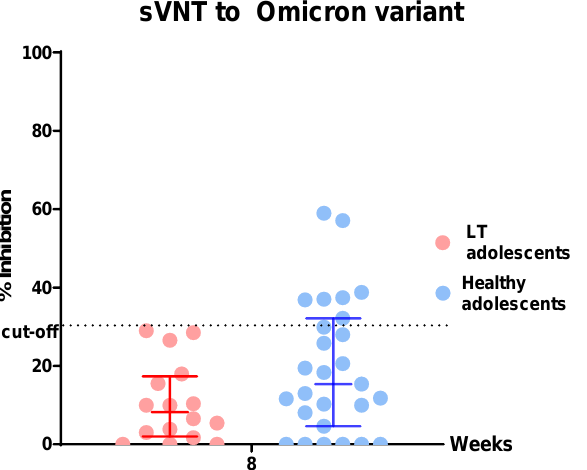
Figure 1. Comparing anti-RBD immunoglobulin (Ig) after completion of BNT162b2 vaccination in liver-transplanted adolescents and healthy adolescents. Data points are reciprocals of the individual. Line indicates geometric mean titer and bar indicates 95% confidence interval. * indicates p < 0.05; ** indicates p < 0.01. Figure 2